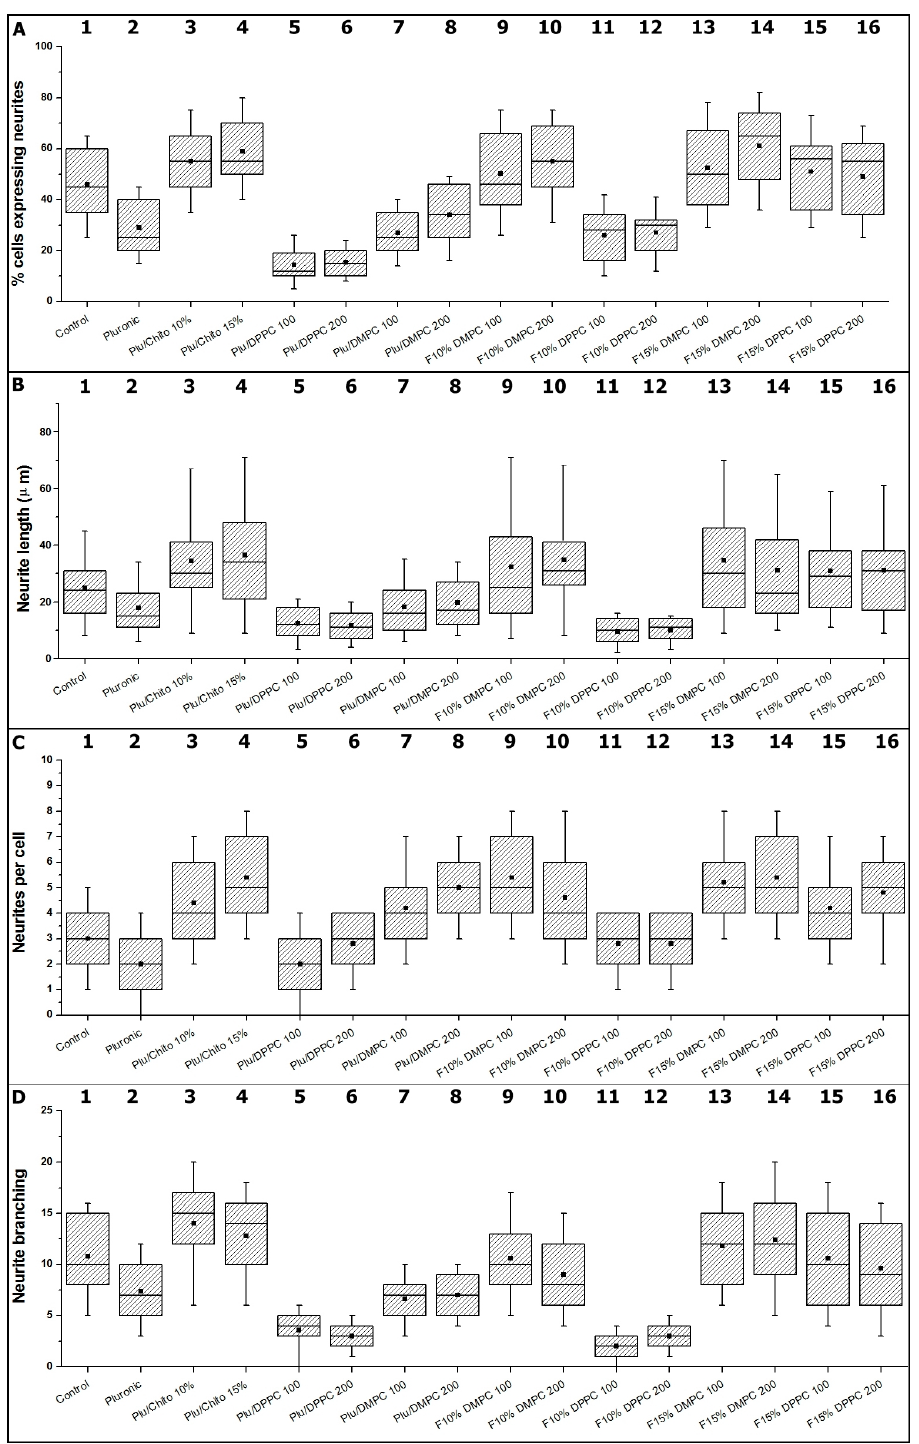
Figure 4. Analysis of neurite outgrowth parameters; Box-and-whisker plots of ( A ) Per cent cells expressing neurite; ( B ) Neurite length; ( C ) Neurites per cell; ( D ) Neurite branching. (n = 5, p < 0.005). Boxes enclose 25th and 75th percentiles of each distribution and are bisected by the median; whiskers indicate 5th and 95th percentiles. Boxes from 1 to 4 represent of effect of chitosan on pluronic F127 on PC12 cellular differentiation, boxes from 5 to 8 represent of effect of Liposomes on pluronic F127 on PC12 cellular differentiation, boxes from 9 to 12 represent of effect of Liposomes on Pluronic F127/Pluronic F127-Chitosan 10% on PC12 cellular differentiation and boxes from 13 to 16 represent of effect of Liposomes on Pluronic F127/Pluronic F127-Chitosan 15% on PC12 cellular differentiation.